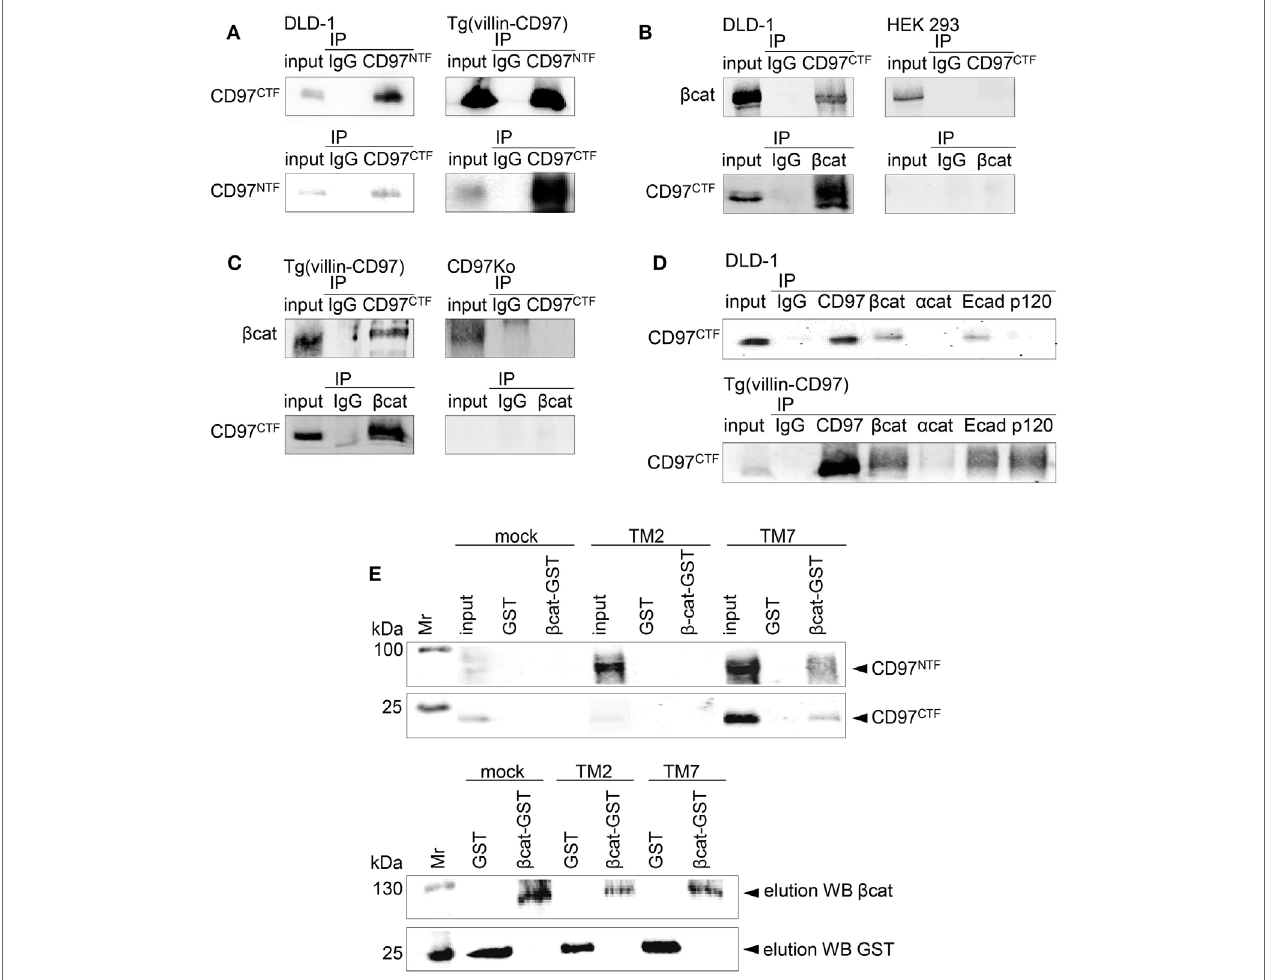
FigUre 2 | CD97 binds β -catenin. (a) The N-terminal (NTF) and C-terminal fragment (CTF) of CD97 were associated in DLD1 cells (left panel) and in the colon of Tg(villin-CD97) mice (right panel). Input control and immunoprecipitates (IP), obtained either with IgG or with CD97 NTF- and CTF-specific antibodies (Abs), were analyzed with a CD97 Ab detecting the other fragment, as indicated. (B,c) CD97 and β -catenin co-immunoprecipitated in CD97-positive DLD1 cells [ (B) , left panel] and in colonic lysates of Tg(villin-CD97) mice [ (c) , left panel]. HEK293 cells, only slightly positive for CD97 [ (B) , right panel], and CD97 knock-out (Ko) mice [ (c) , right panel] served as negative controls. (D) Next to β -catenin, CD97 co-immunoprecipitated with E-cadherin (Ecad) in DLD1 cells (upper picture) and with Ecad and p120-catenin in Tg(villin-CD97) mice (lower picture). (e) upper panel: beads loaded with glutathione S-transferase (GST) or β -catenin-GST were incubated with lysates of HT1080 CD97(EGF125), CD97(EGF125/TM2) cells with a C-terminal truncated CD97 (15), and mock cells. Bound proteins were eluted and CD97 was detected with NTF or CTF CD97-specific Abs by western blotting. Pulldown could be demonstrated only with β -catenin-GST and lysates of HT1080 cells expressing full-length (TM7), but not expressing C-terminal truncated (TM2) CD97. In the lower panel the respective elution controls for β -catenin and GST are